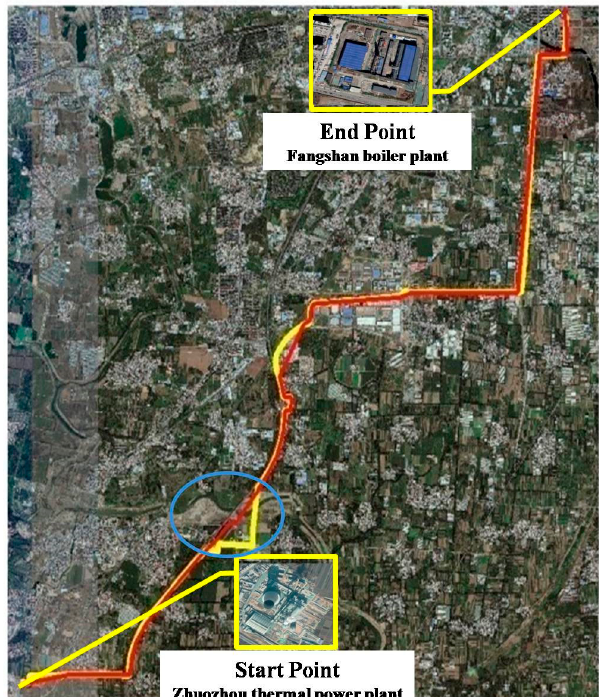
Figure 16. The best route of the modified CS.